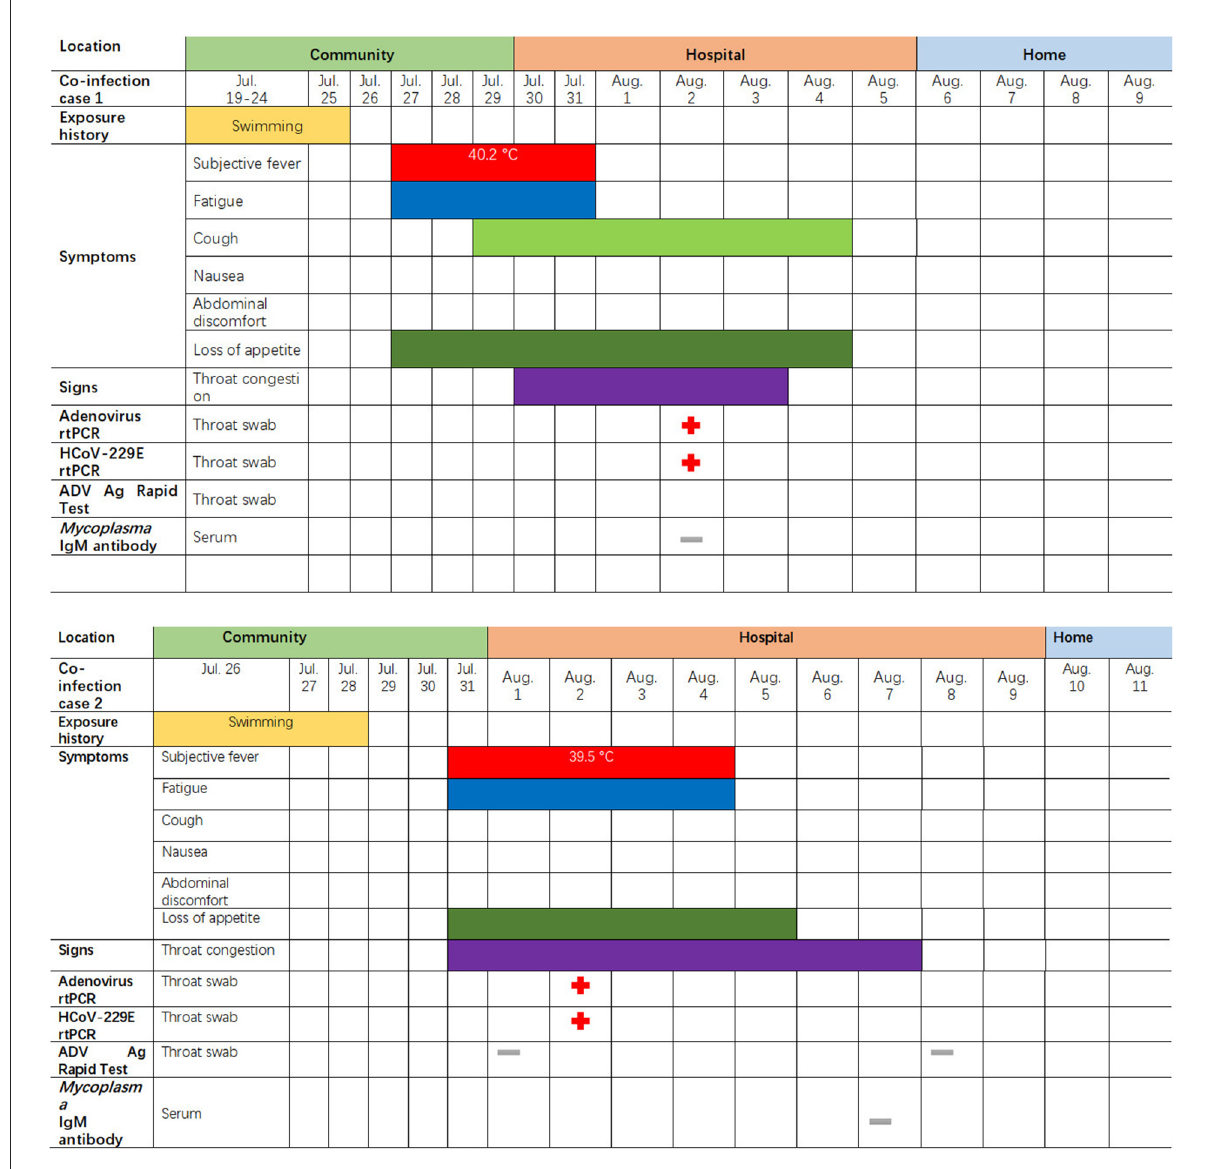
FIGURE1 Symptoms and results of rtPCR testing and antigen rapid test for the two children coinfected with HCoV-229E and adenovirus; they were admitted to different rooms in the same pediatric ward in Lishui, Zhejiang Province, July–August 2019. rtPCR = real-time PCR. ADV = adenovirus. The red cross indicates that the pathogens (adenovirus or 229E) were detected by PCR or rapid antigen detection. The gray – indicates an HCoV-229E negative